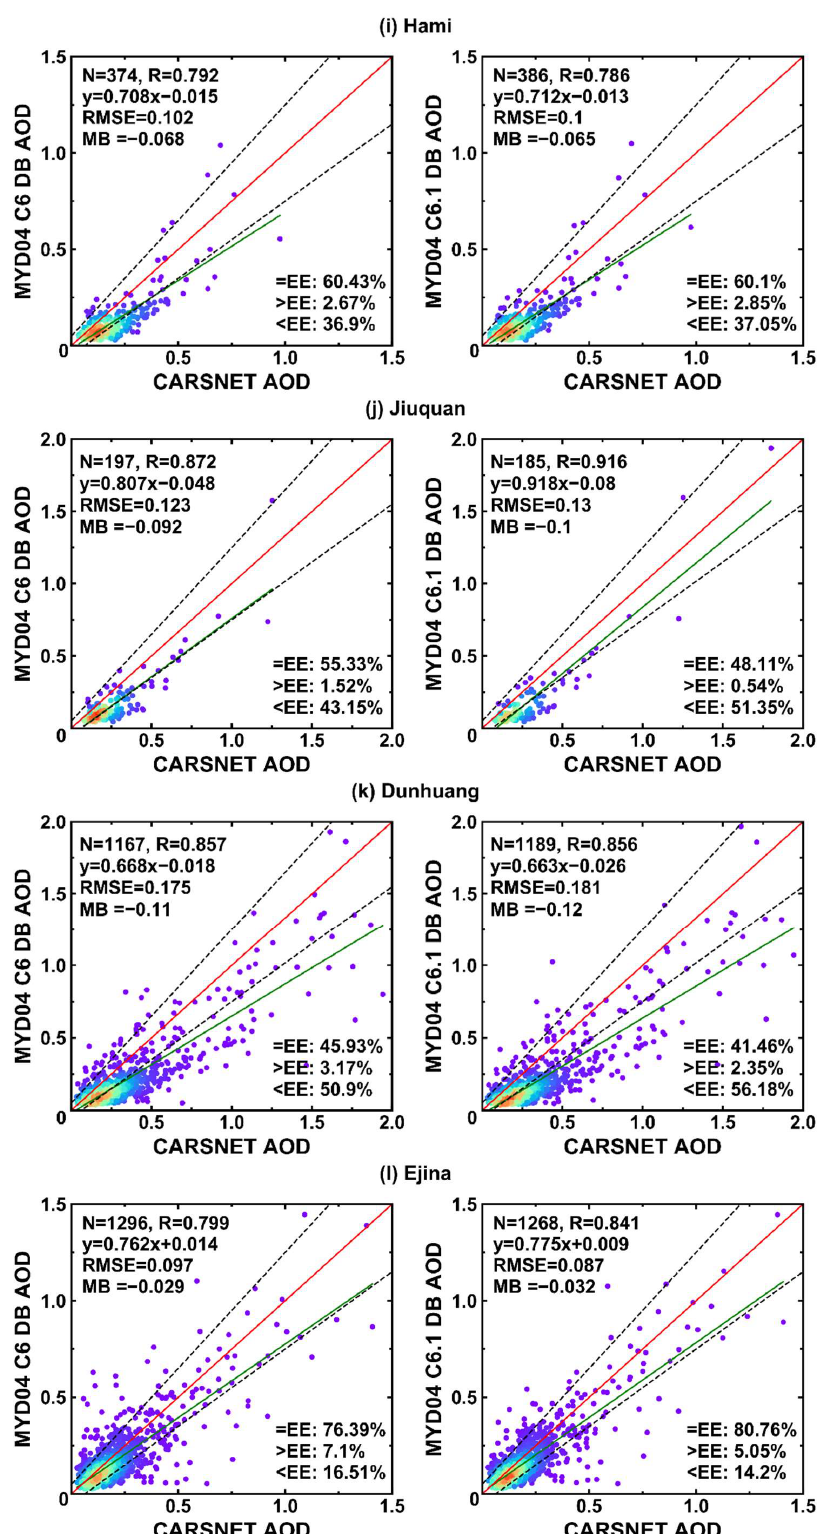
Figure 5. Validation of MODIS C6 ( left ) and C6.1 ( right ) DB AOD against ground-based AOD at 12 desert sites. One-one line, linear regression line, and the EE envelopes are plotted as red solid, green solid, and black dashed lines. ( a ) Tazhong; ( b ) Hotan; ( c ) Minqin; ( d ) Ulate; ( e ) AOE_Baotou; ( f ) Zhurihe; ( g ) Zhangbei; ( h ) Xilinhot; ( i ) Hami; ( j ) Jiuquan; ( k ) Dunhuang; ( l )